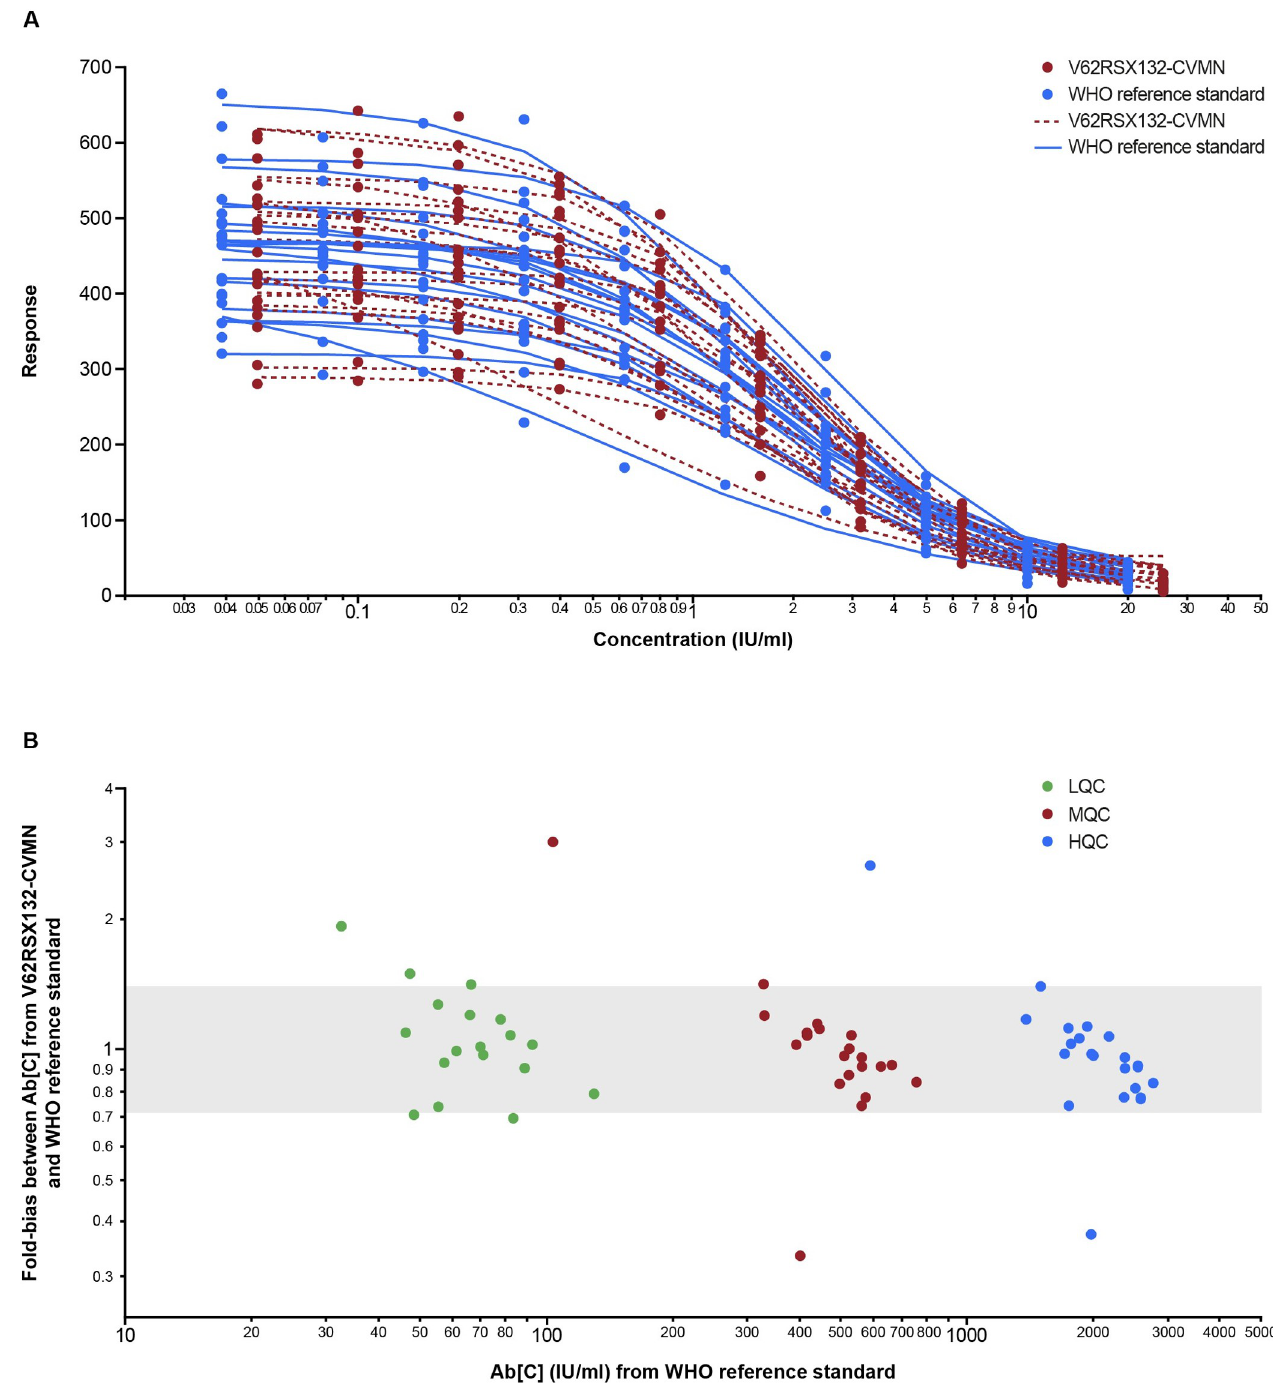
Fig 6. Calibration of MNT RS curve to WHO RS curve. Ten assay runs were performed across 25 days with each plate containing two independent preparations of the V62RSX132-CVMN and two independent preparations of the WHO RS. (A) An overlay of standard curves for V62RSX132-CVMN and WHO RS after application of new assignments for the V62RSX132-CVMN. (B) Fold-bias estimates comparing interpolated QCs Ab[C] (IU/ml) utilizing PPD V62RSX132-CVMN to interpolated QCs Ab[C] (IU/ml) utilizing WHO RS. Graph symbol numbers represent the run number, and the highlighted area represents ± 1.40-fold. RS = reference